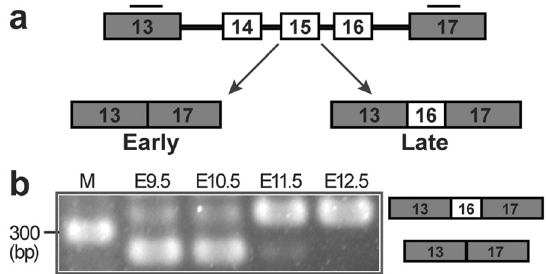
Figure 4. Primitive erythroblasts undergo developmental-specific alternate splicing of Epb41 as they transition from BasoE at E10.5 to PolyE at E11.5. (A) Epb41 , encoding protein 4.1 R, undergoes maturation-specific alternative splicing in definitive erythropoiesis. Epb41 exon 16 encodes a high spectrin-affinity domain and is exclusively incorporated into Epb41 transcripts in definitive erythroblasts at late maturational stages. Bars represent the location of the primer pairs used to detect Epb41 isoforms by RT-PCR. Constitutive exons are gray and alternatively spliced exons are white. ( b ) Splice variants of Epb41 in primitive erythroblasts during maturation were detected by RT-PCR. A representative analysis of 3 independent experiments is shown. Exons included in the bands are indicated in the right panel. M, DNA